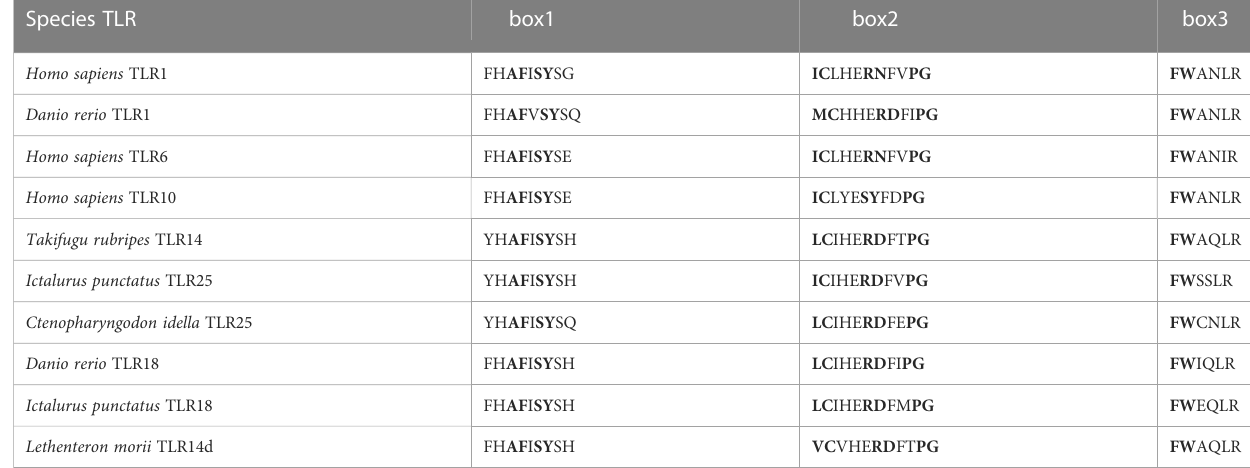
TABLE 2 Multiple sequence alignments of LmTLR14d TIR domains with those of other vertebrates. Species TLR box1 box2